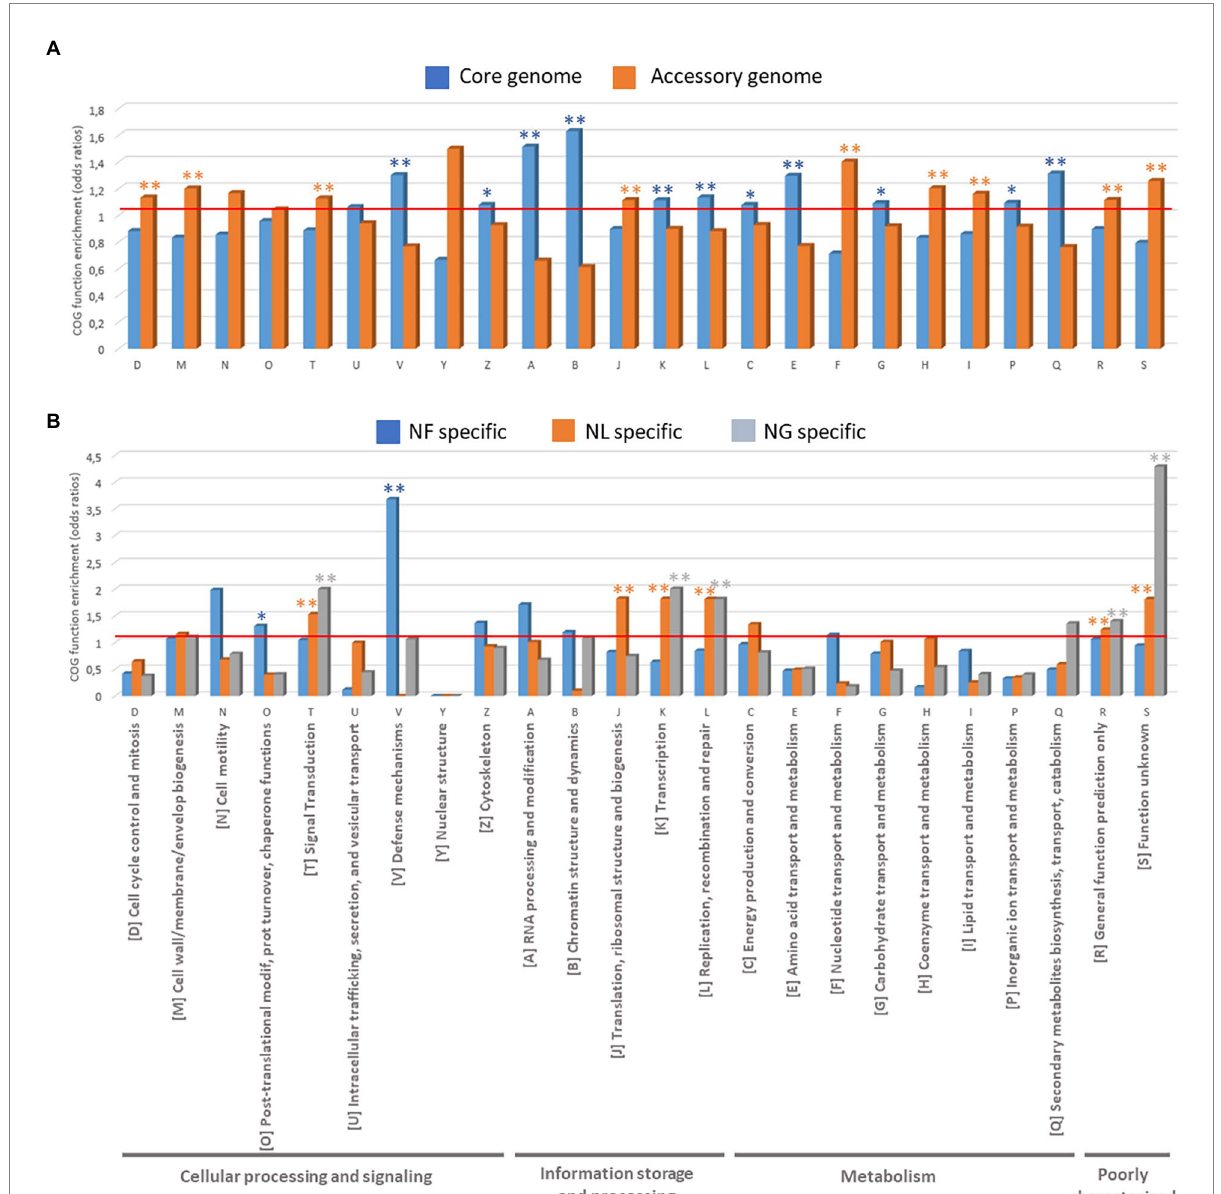
FIGURE 5 Functional analyses of Naegleria pangenome based on COG function enrichment (odd ratios). (A) COGs present in Naegleria core and accessory genomes and (B) COGs specifically detected in N. fowleri (NF), N. lovaniensis (NL) and N. gruberi (NG)